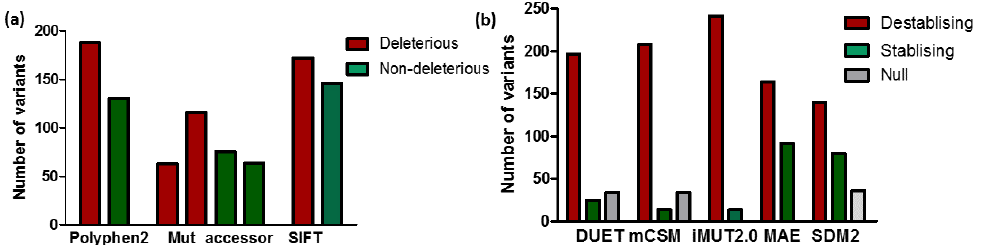
Figure 1. Effect of mutations by sequence and structure-based predictions : ( a ) deleterious (red) or non-deleterious (green) mutations in MC4R as predicted by sequence-based tools; ( b ) destabilizing (red), stabilizing (green), or null (grey) as predicted by structure-based analyses.